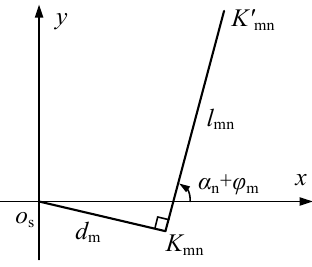
Figure 4. The Distance between Laser Beam and Rotary Axis of the Measuring Rod.